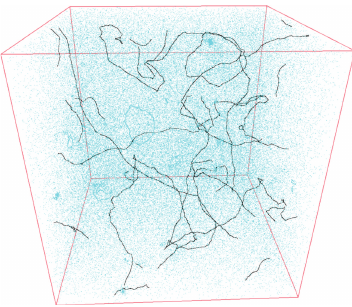
Figure 6: String network configuration in the matter era when the horizon fills the whole simulation box. String loops with a length smaller than the distance to the horizon appear in blue.